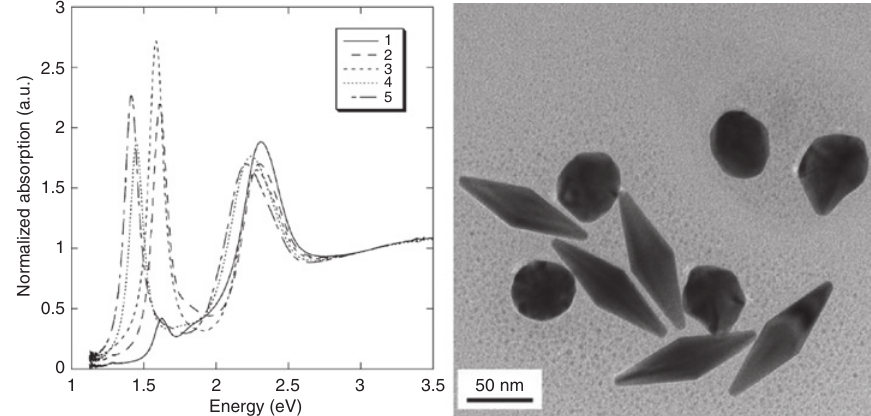
Figure 10: Left: UV/Vis spectra of different gold nanobipyramid solutions prepared with various silver amounts. Right: TEM picture of bipy- ramids. Adapted with permission from Ref. [20]. Copyright (2015) American Chemical